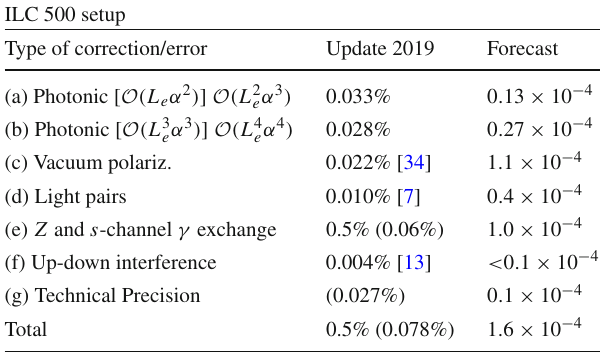
Table 3 Forecasts of the total (physical+technical) theoretical uncer- tainty for the ILC 500 luminosity calorimetric detector with the angular range of 31–77 mrad. Description of photonic corrections in square brackets is related to the 2nd column. The numbers in curly brackets in lines (e) and “Total” refer to a fictitious situation with all Born-level interferencesincludedin BHLUMI .Thetotalerrorissummedinquadra- ture. A technical error is not included in “Total”